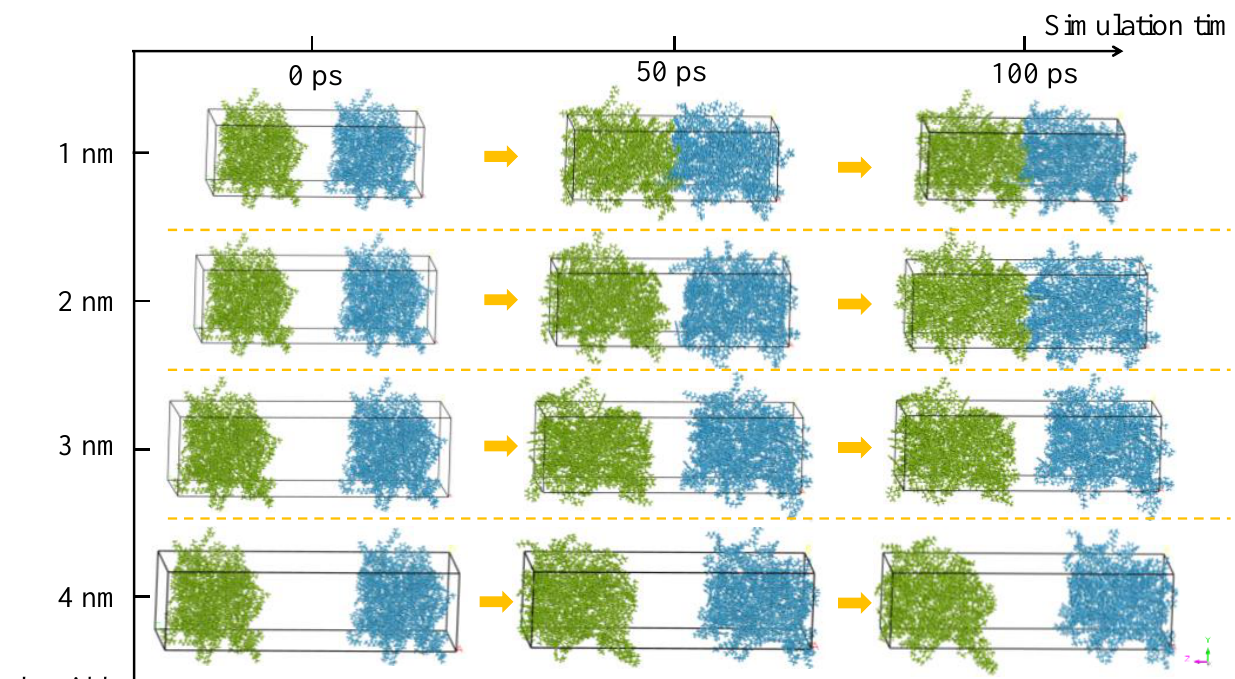
Figure 7. Snapshots of asphalt self-healing model with crack width of 1 – 4 nm.